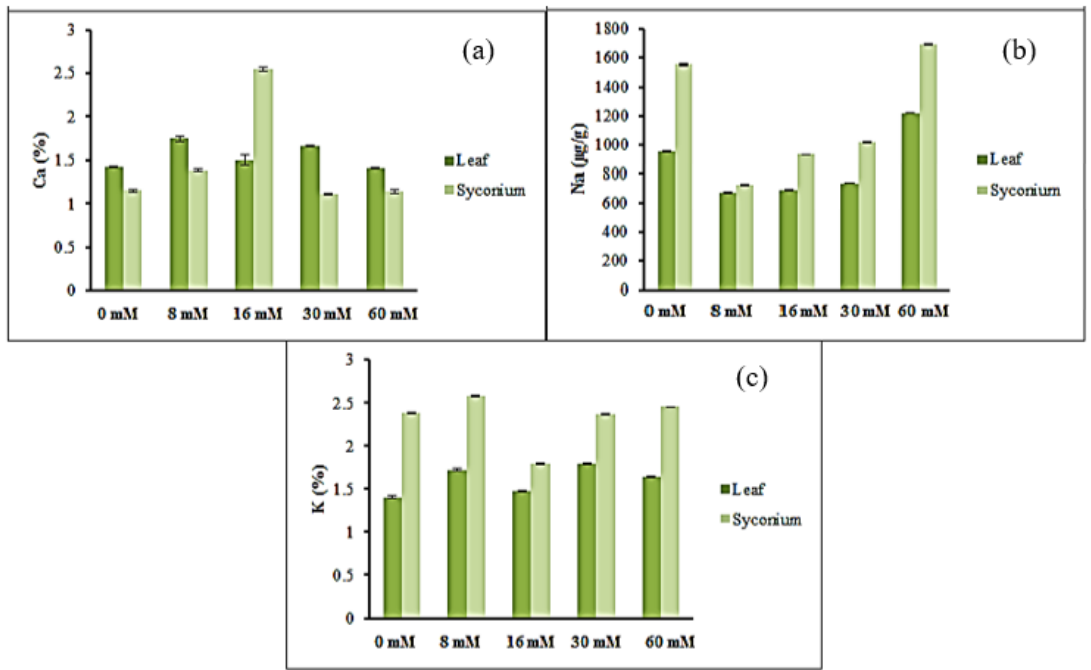
Figure 2. The e ff ect of H 2 O 2 on ( a ) calcium (Ca), ( b ) sodium (Na), ( c ) potassium (K) in leaf and Figure 2. The effect of H 2 O 2 on (a) calcium (Ca), (b) sodium (Na), (c) potassium (K) in leaf and syconium of Ficus deltoidea var deltoidea plant. Error bars indicate ( ± S. syconium of Ficus deltoidea var deltoidea plant. Error bars indicate (± S. E).